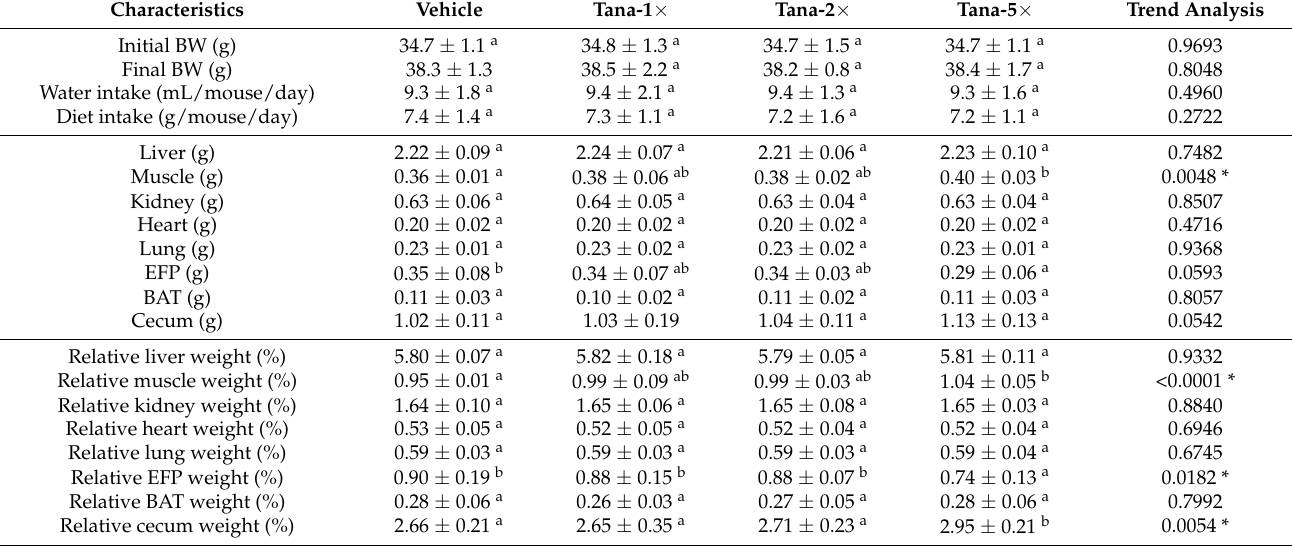
Table 2. Effect of Tana supplementation on various parameters.